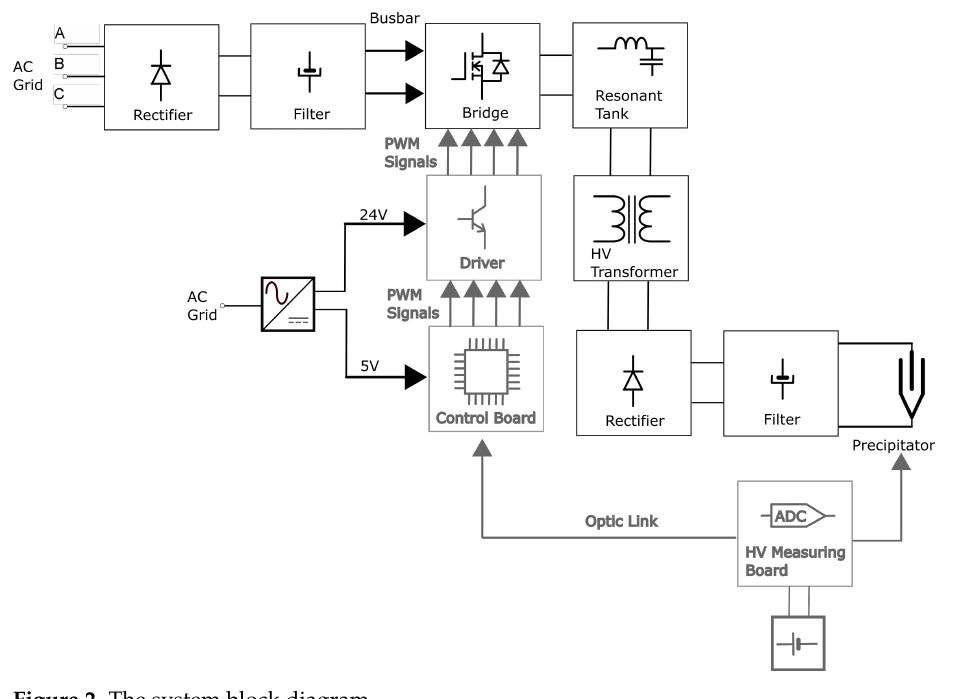
Figure 2. The system block diagram.